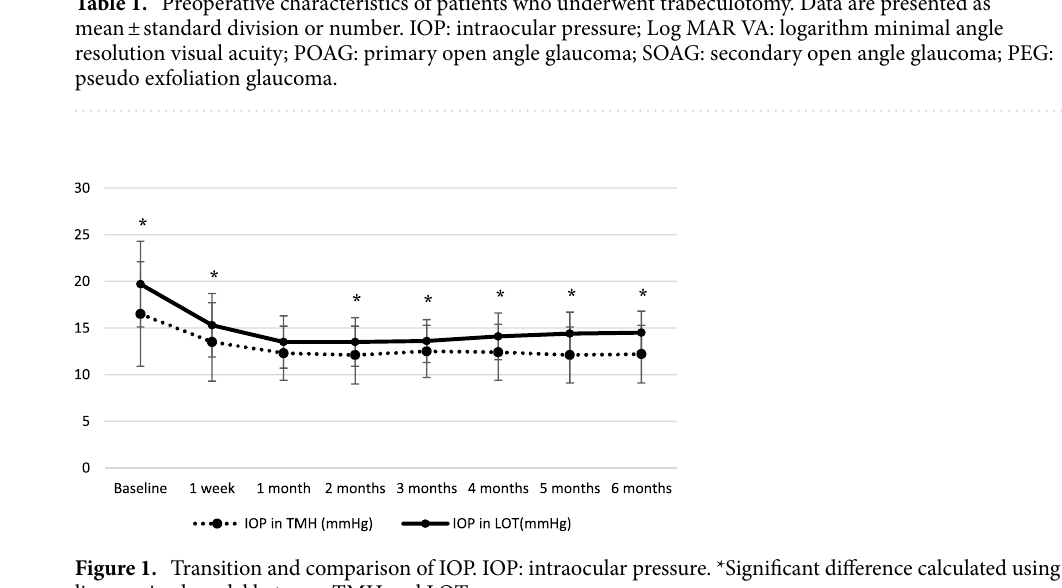
Figure 1. Transition and comparison of IOP. IOP: intraocular pressure. *Significant difference calculated using linear mixed model between TMH and